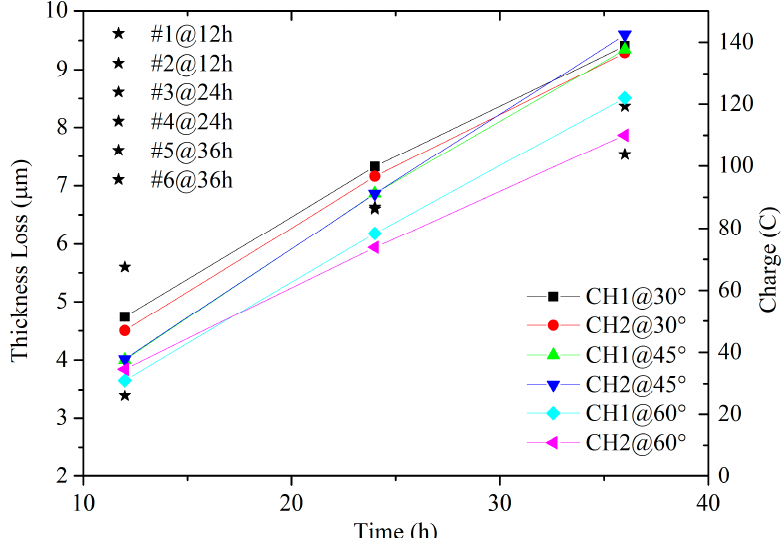
Figure 9. The relationship between the electric charges of the sensors and the thickness losses of the coupons in salt spray tests.